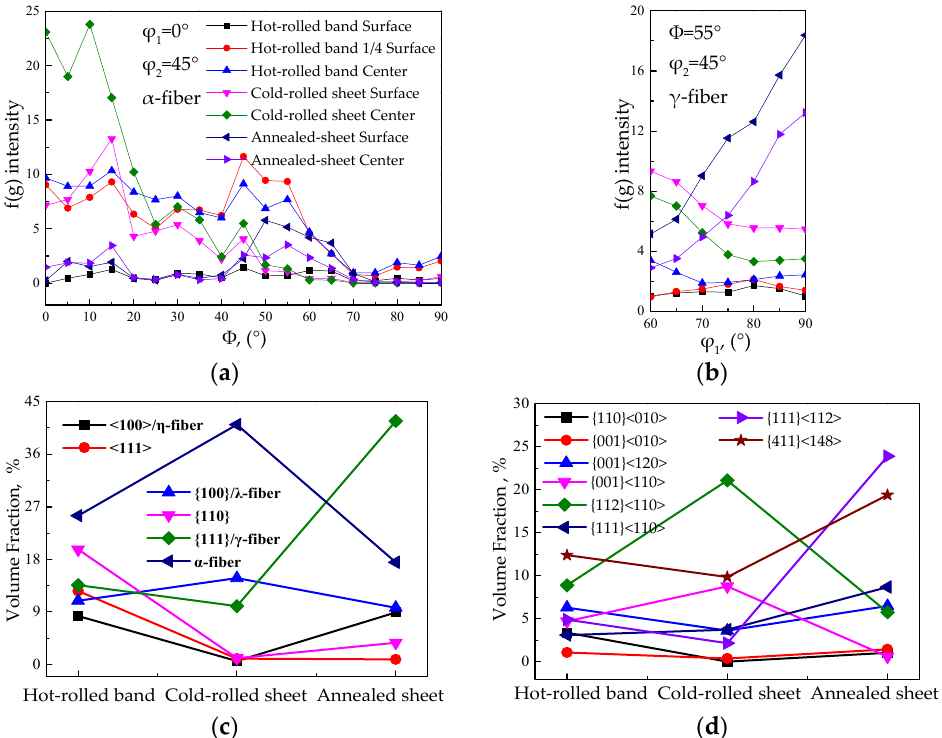
Figure 3. Orientation line distribution of α , γ textures and volume fraction distribution of textures of Fe-0.65%Si non-oriented electrical steel. ( a ) α textures, ( b ) γ textures, ( c ) and ( d ) volume fraction distribution of textures.